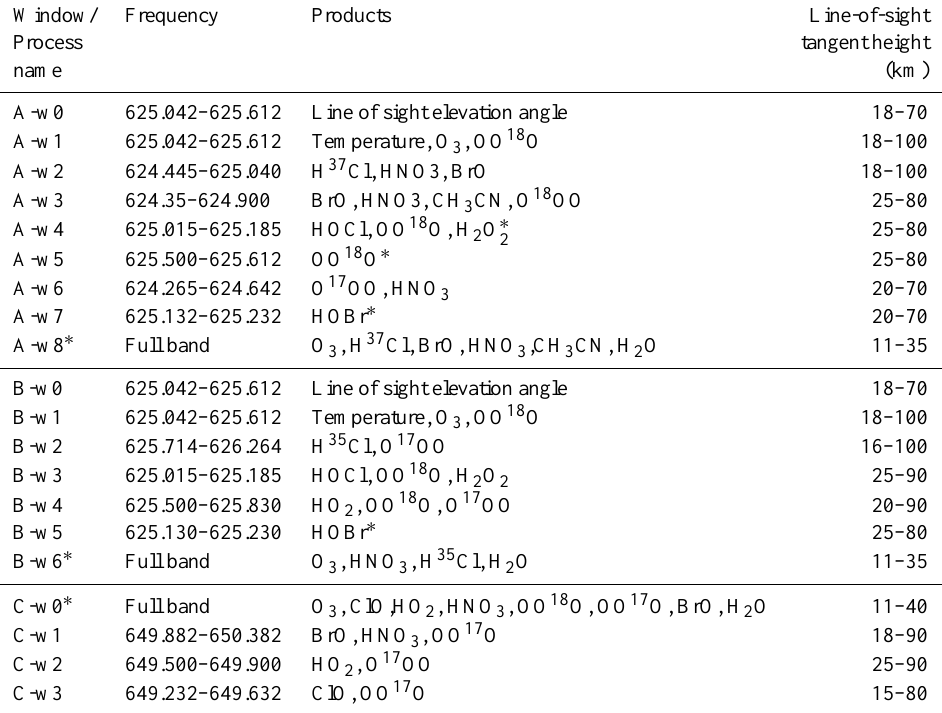
Table 2. SMILES L2 research data produced by the version-2 algorithms. The products list for each process or window is given along with the frequency range and the line-of-sight altitude range. The actual vertical range for a good retrieval depends on the signal strength.